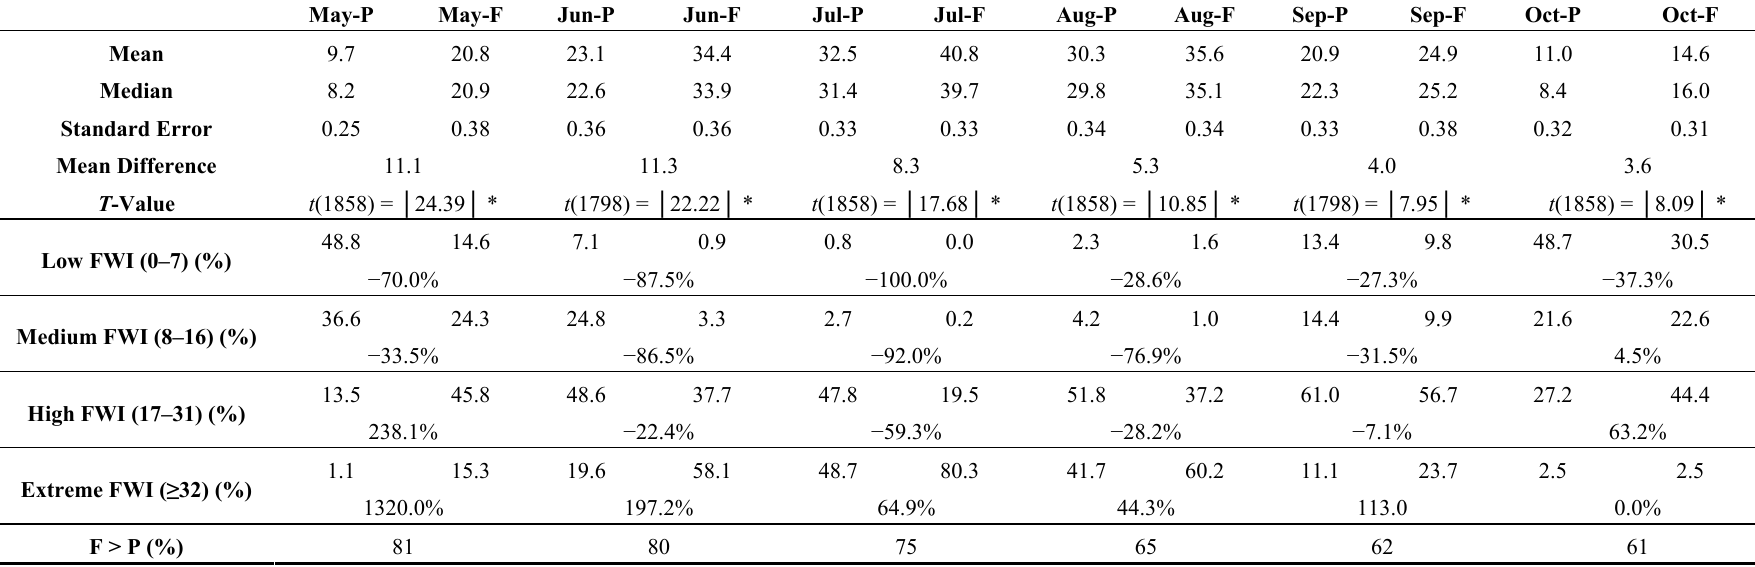
Table 3. Fire season monthly FWI for the present (P) and future (F) time periods with descriptive statistics, differences and t -test comparisons of the means for each month. Information is provided regarding the percentages of FWI values that are higher between the two time periods and the percentages of monthly FWI values falling on each of the four fire danger